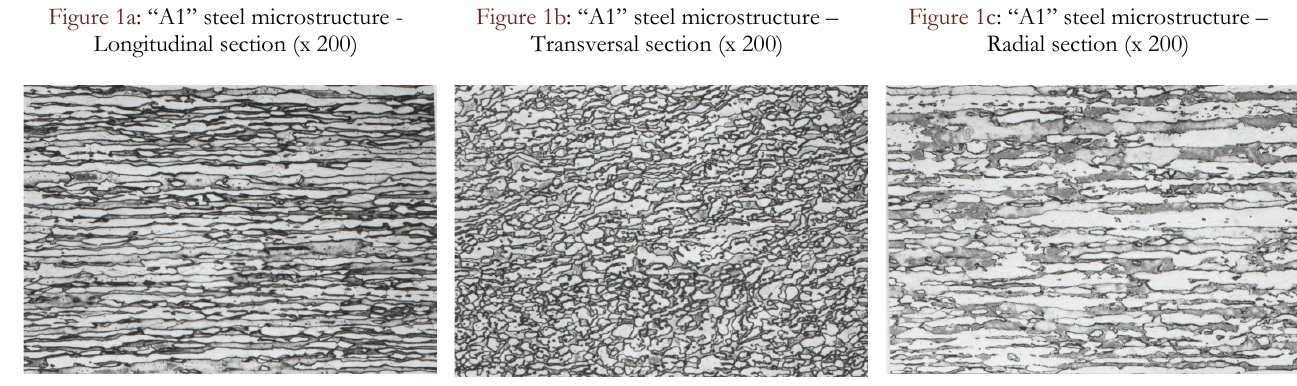
Figure 2b: “A1L” steel microstructure - Transversal section (x 200).